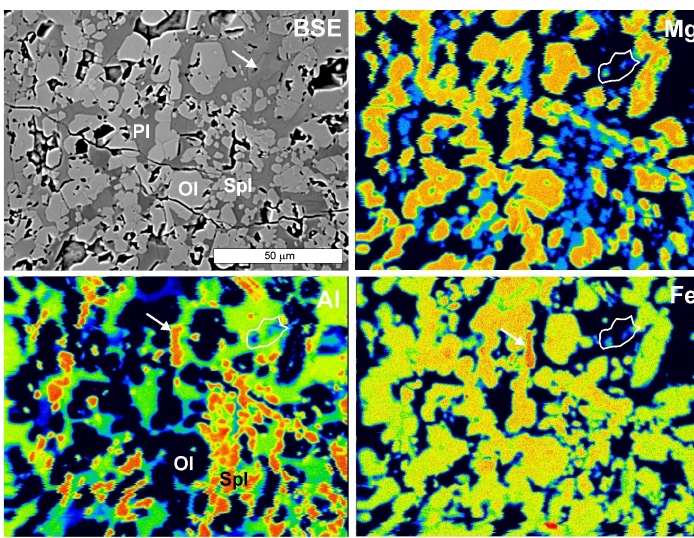
Figure 10. BSE image and false color-coded X-ray maps of pseudomorph with irregular amphibole grain (white arrow, contoured in X-ray maps) associated with olivine (Ol), Mg,Al-spinel (Spl) and plagioclase (Pl). Sample Cam-15. Note also hercynite grain indicated by white arrows in Al and Fe distribution maps. Warmer colors (red, orange) denote higher concentrations. Table 2. Representative EPMA analyses and crystal chemistry of amphibole (sample